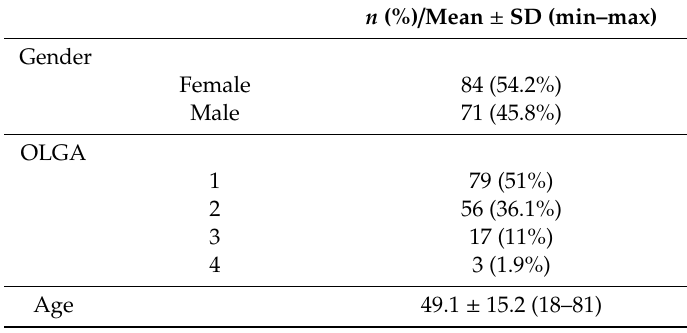
Table 5. Demographic and clinical descriptive statistics of